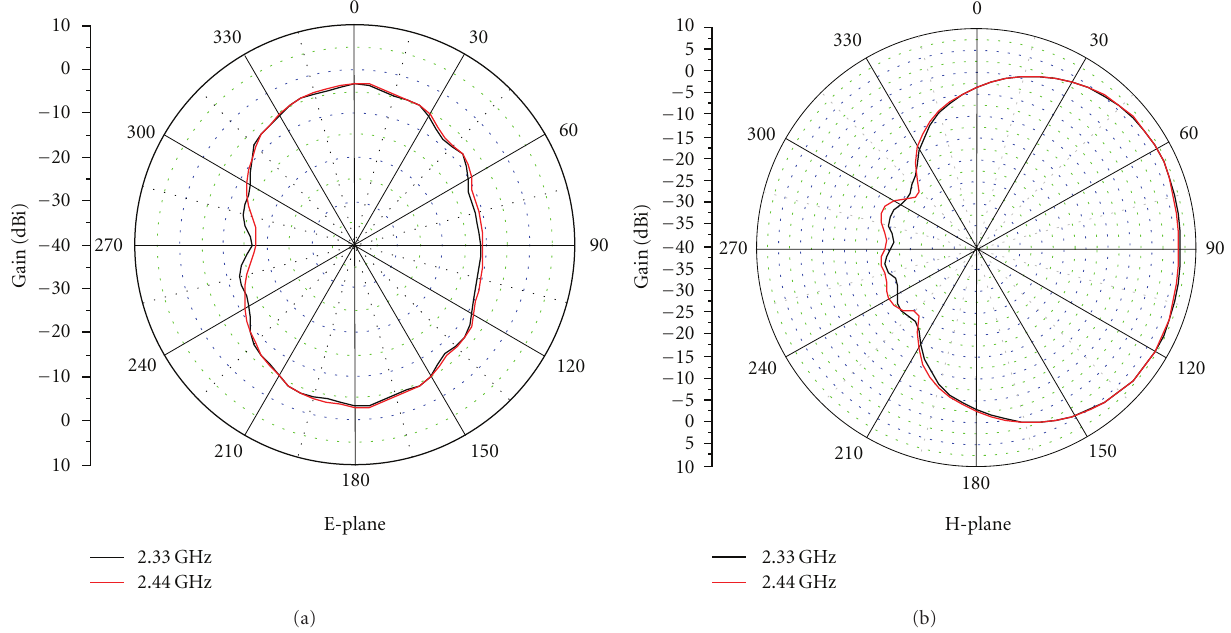
Figure 12: Simulated radiation diagrams of dipole on reflector plate at 2.44 GHz and 2.33 GHz.